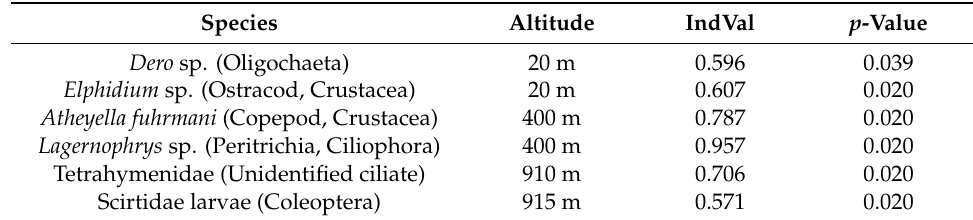
Figure 3. Ordination scatterplot resulting from a Constrained Correspondence Analysis of eukaryotic communities present in bromeliad cisterns at four different altitudes. Percentages of the variation explained by each ordination axis are indicated parenthetically. Different colors (polygons and points) represent different altitudes. Gray points represent eukaryotic species. Hollow points indicated the position in the ordination space of taxa selected in the indicator species analysis (see methods and results). Indicator species’ name colors match the altitude they were related to. Table 3. Indicator species per altitude, with the statistical significance and strength of association described by the ‘IndVal’ index.